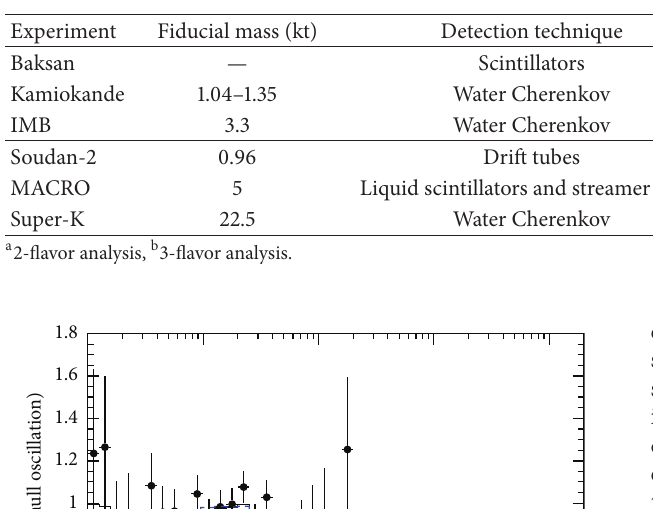
Table 2: Main parameters and results of some relevant atmospheric neutrino experiments.